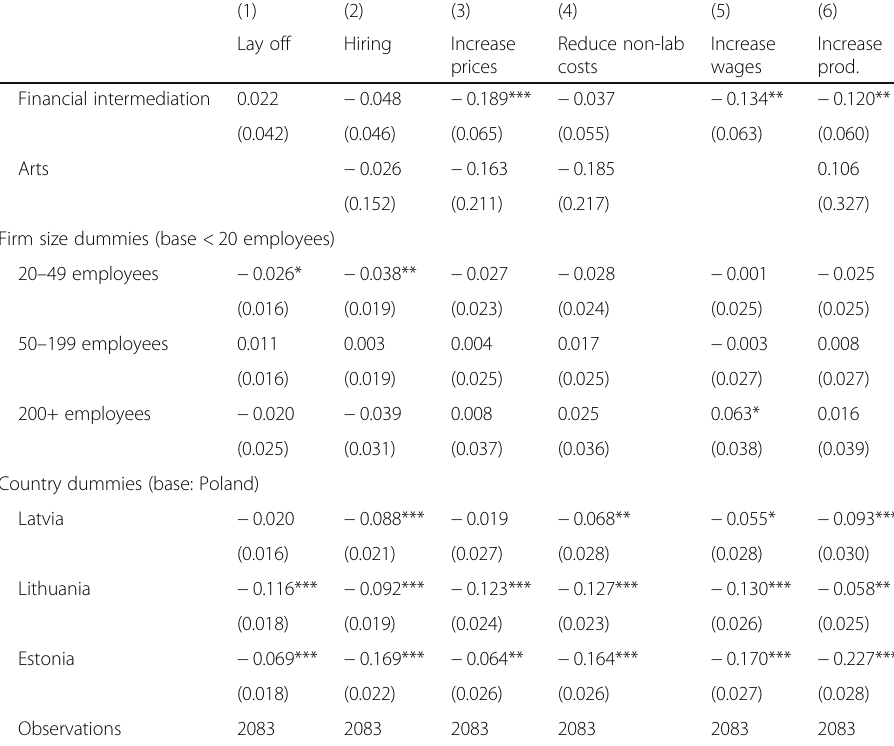
Table 12 Multivariate probit of adjustment channel relevance, average marginal effects (all channels; sample restricted to Baltic countries and Poland) (Continued)